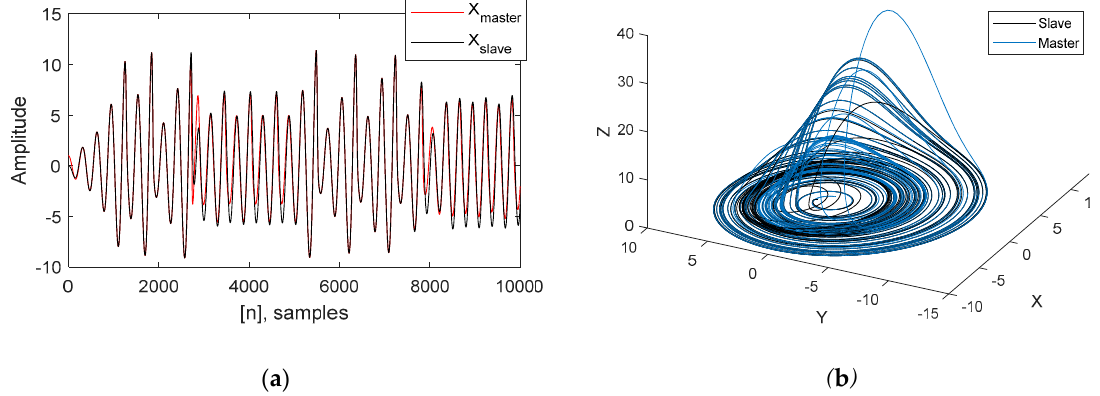
Figure 2. The dynamics of master (1) and slave (2) systems ( a ) and corresponding attractors ( b ).